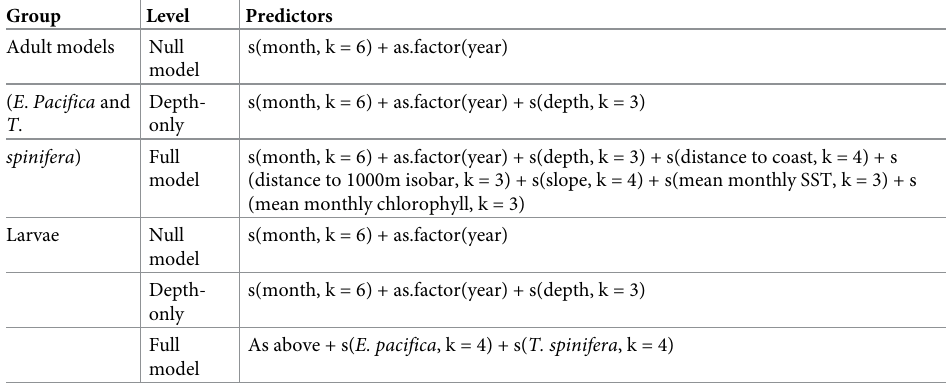
Table 1. Model formulas, using pseudo-R code, for E . pacifica , T . spinifera and euphausiid larvae, including null model, depth- only model and full covariate model after covariate